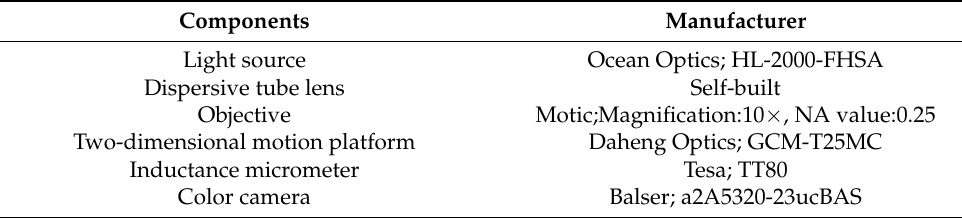
Table 1. List of components in the experimental platform.